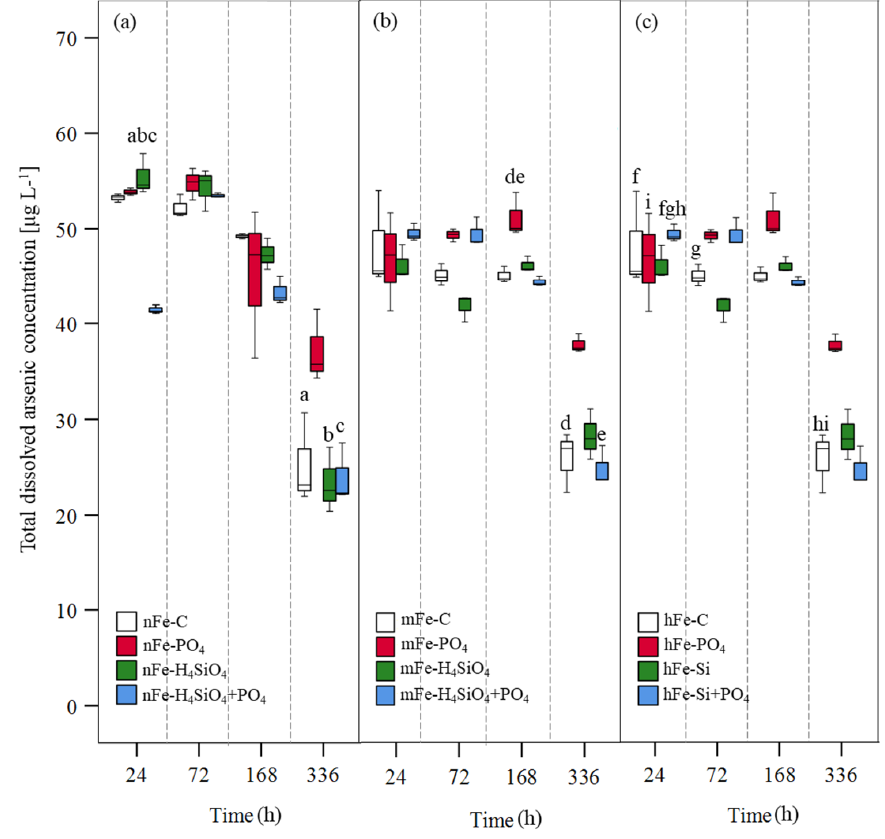
Figure 2. Box plots represent the total arsenic concentrations with different treatments and different goethite (Fe) concentrations (no Fe: nFe; medium Fe: mFe; and high Fe: hFe) versus time during the onset of anoxic conditions. Control: C; phosphate: PO 4 ; and silicic acid: H 4 SiO 4 . The boxes show quartiles and the medians; the whiskers denote data within 1.5 times the interquartile range; data from incubation over time ( n = 3). Boxes with same letters are significantly different from each other ( p < 0.05).